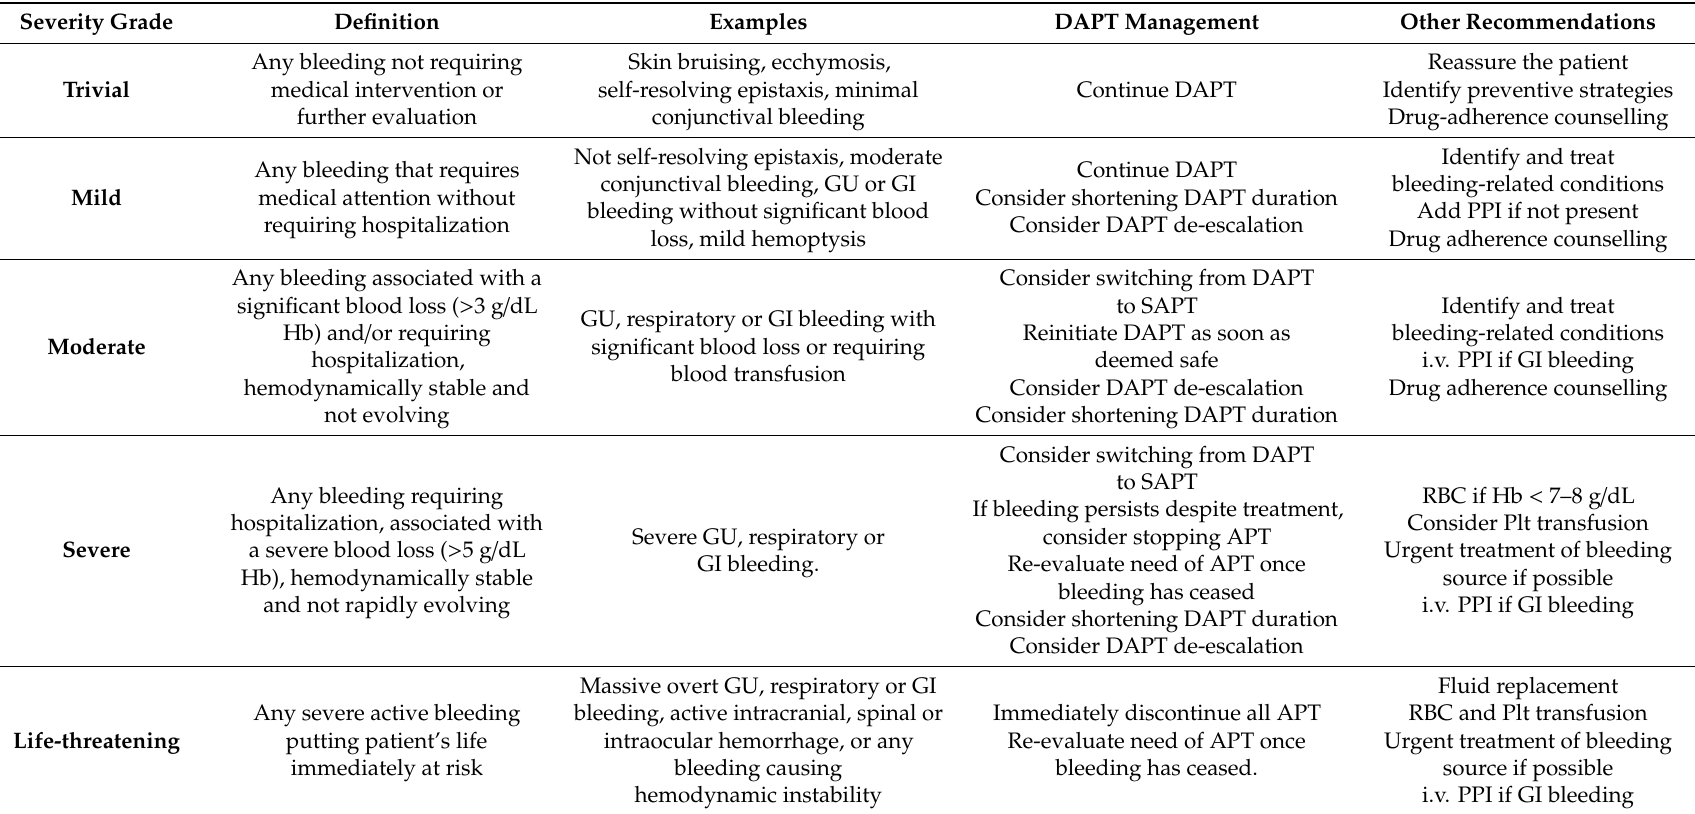
Table 4. Definition and management of bleeding in patients on dual antiplatelet therapy (modified from European Guidelines [7]). DAPT, dual antiplatelet therapy; GI, gastrointestinal; GU, genitourinary; Hb, hemoglobin; i.v., intravenous; Plt, Platelets; PPI, proton pump inhibitor; RBC, red blood cell; SAPT, single antiplatelet